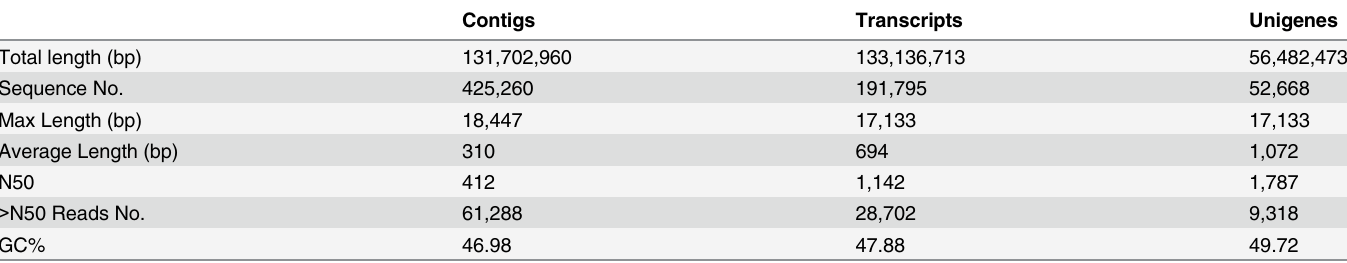
Table 1. Summaries of cDNA libraries sequencing of grass carp by Illumina NextSeq 500 platform.